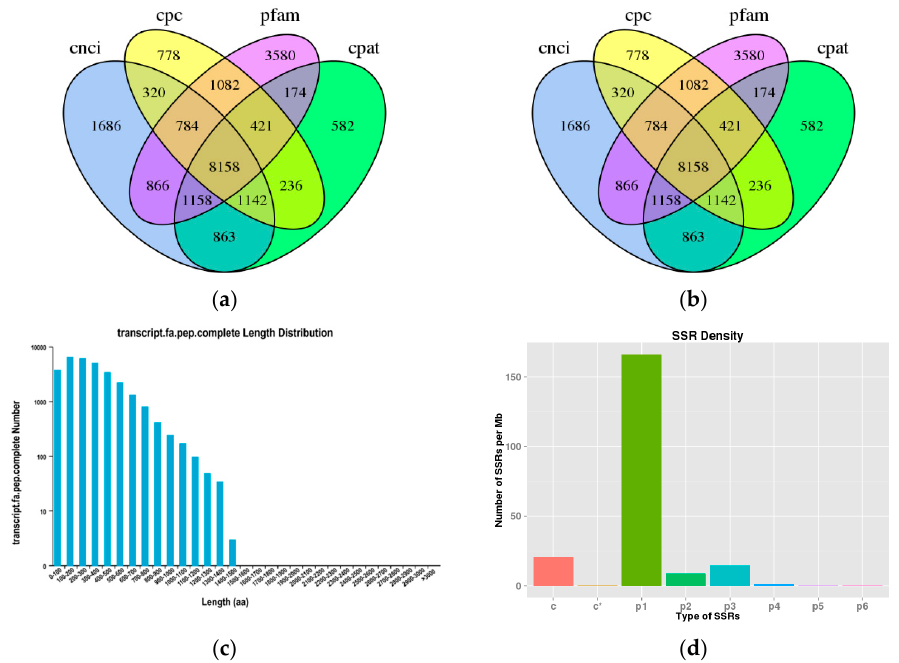
Figure 1. Functional annotation and structural analysis of the full-length transcriptome. ( a ) Functional annotation of non-redundant (NR), gene ontology (GO), clusters of orthologous groups (COG), euKaryotic ortholog groups (KOG), Kyoto Encyclopedia of Genes and Genomes (KEGG), Pfam, non-supervised orthologous groups (eggNOG) and SwissProt database results. ( b ) Venn diagram